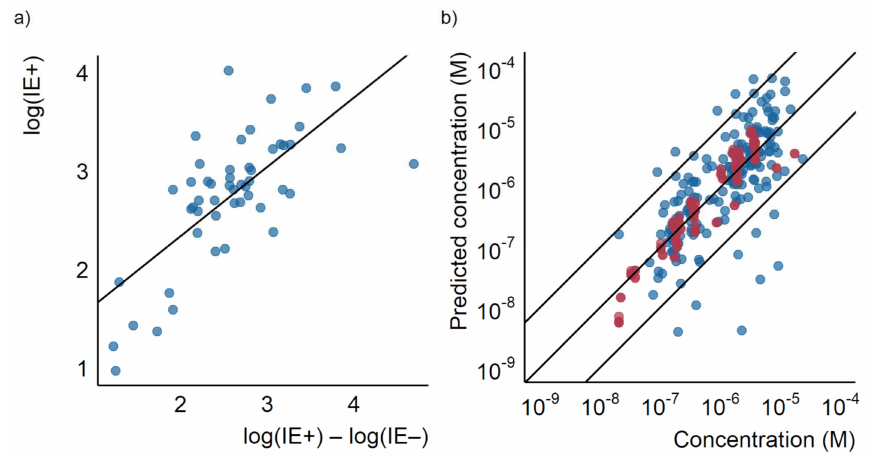
Figure 5. ( a ) A scatterplot showing the difference between the logarithm of the ionization efficiencies ion positive and negative modes measured by Liigand et al. [35] plotted against the logarithm of the ionization efficiency ion positive mode as well as the regression line. ( b ) The predicted concentration for the test (red) and training (blue) set based on the linear model using only the ratio of the logarithmic response factors plotted against the known